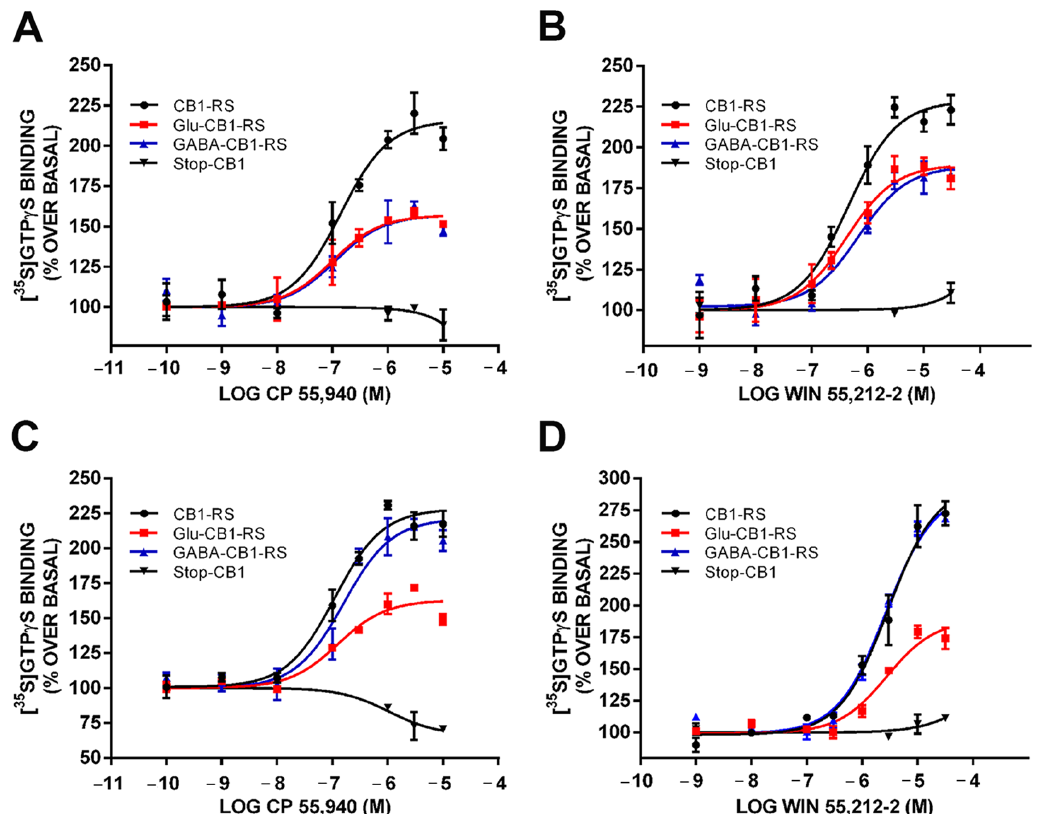
Figure 5. CB1 receptor coupling to G α i/o proteins in synaptosomes obtained from frontal cortical and hippocampal tissue of Glu-CB1-RS, GABA-CB1-RS, CB1-RS, and Stop-CB1 mice. CP 55,940- ( A ) and WIN 55,212-2- ( B ) stimulated [ 35 S]GTP γ S binding in frontal cortical synaptosomes. CP 55,940- ( C ) and WIN 55,212-2- ( D ) stimulated [ 35 S]GTP γ S binding in hippocampal synaptosomes. Concentration–response curves were constructed using mean values ± SEM from triplicate data points of three independent experiments. Emax values are expressed as % specific [ 35 S]GTP γ S bound of